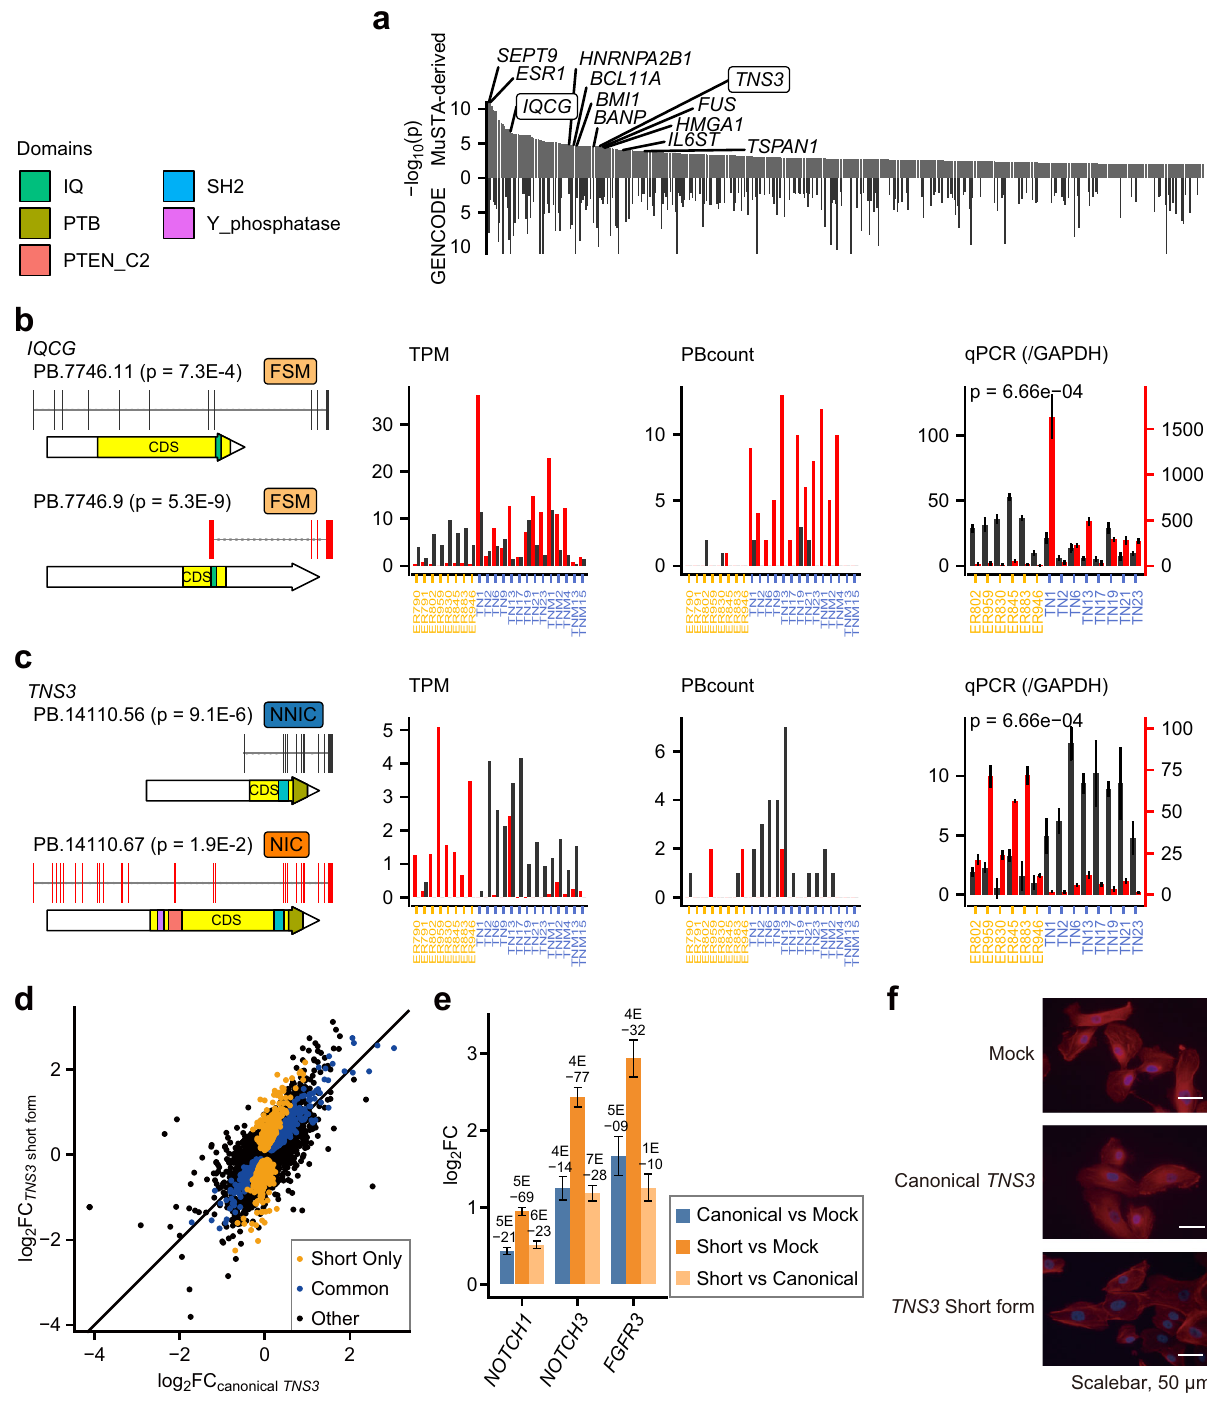
Next, we conducted Gene Ontology and KEGG pathway Fig. 13d, e). In DGE genes, pathways related to peptidase processing, ectodermal development, and the cell cycle were enriched. Curiously, eight out of the top ten biological processes enriched in DTU genes were associated with molecular binding.